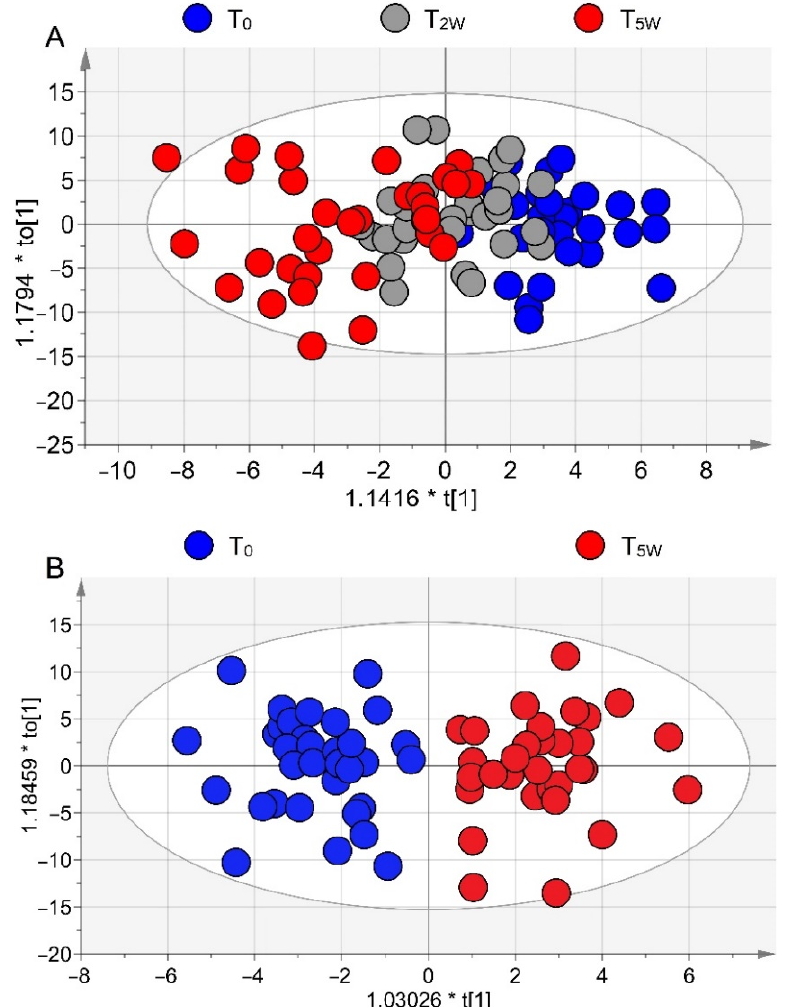
Figure 2. Orthogonal Projections to Latent Structures Discriminant Analysis (OPLS-DA) of EBC samples collected from COPD patients during the PR cycle. ( A ) Scores plot showing the degree of separation of the full model (T 0 , blue circles; T 2W , gray circles; and T 5W , red circles). ( B ) Scores plots showing the degree of separation of the model between T 0 (blue circles) and T 5W (red circles) patients. The labels t[1] and t[2] along the axes represent the scores (the first two partial least-squares components) of the model, which are sufficient to build a satisfactory classification model.